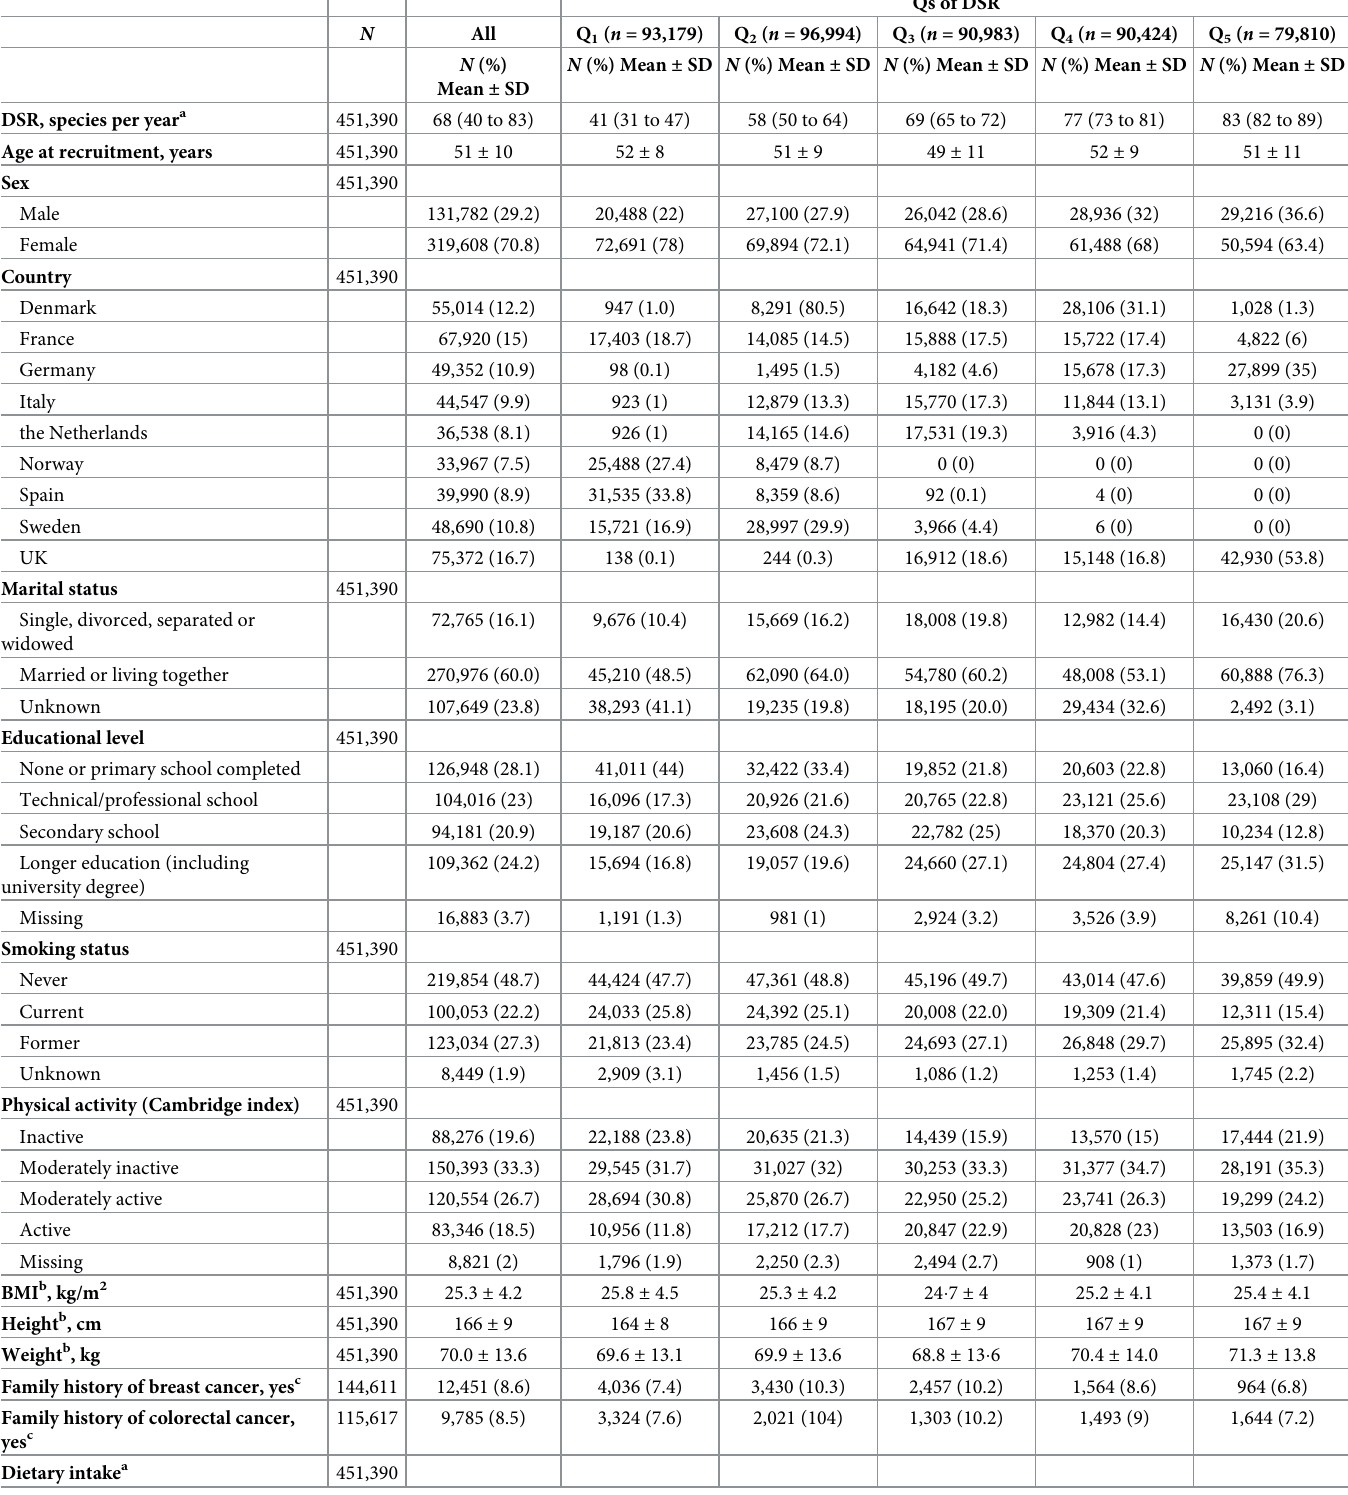
Table 1. Baseline characteristics of participants overall and by Qs of food biodiversity, EPIC cohort, 1992 to